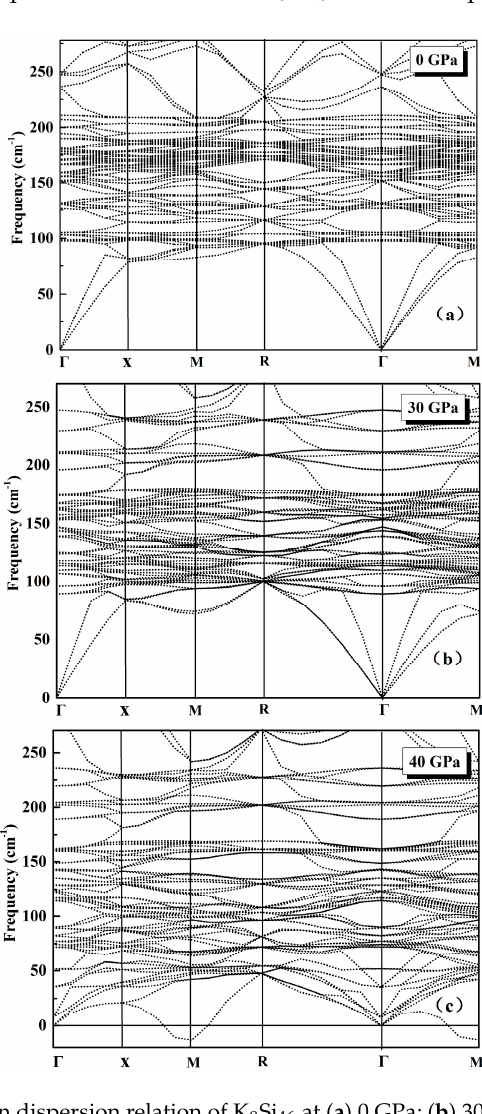
8 Si 46 at ( a ) 0 GPa; ( b ) 30 GPa and ( c ) 40 GPa.